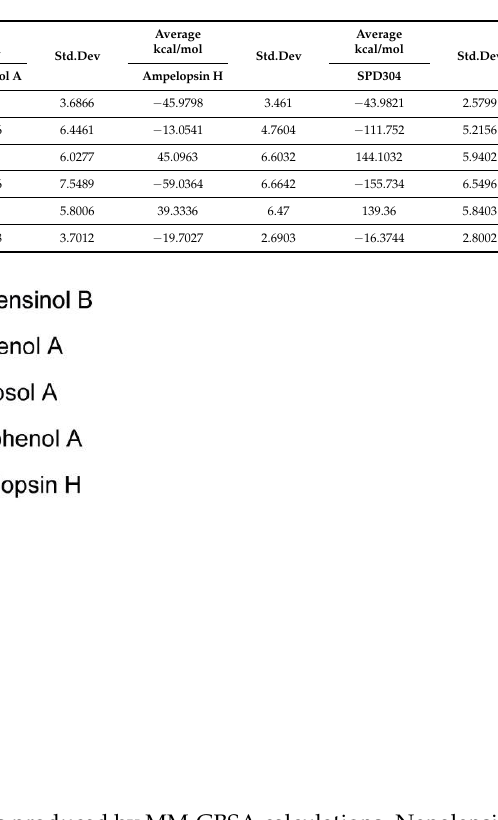
Table 1. Energetic analysis for TNF in complex with Miyabenol A, Nepalensinol B, Flexuosol A, Kobophenol A and Ampelopsin H, as obtained by MM-GBSA calculations.